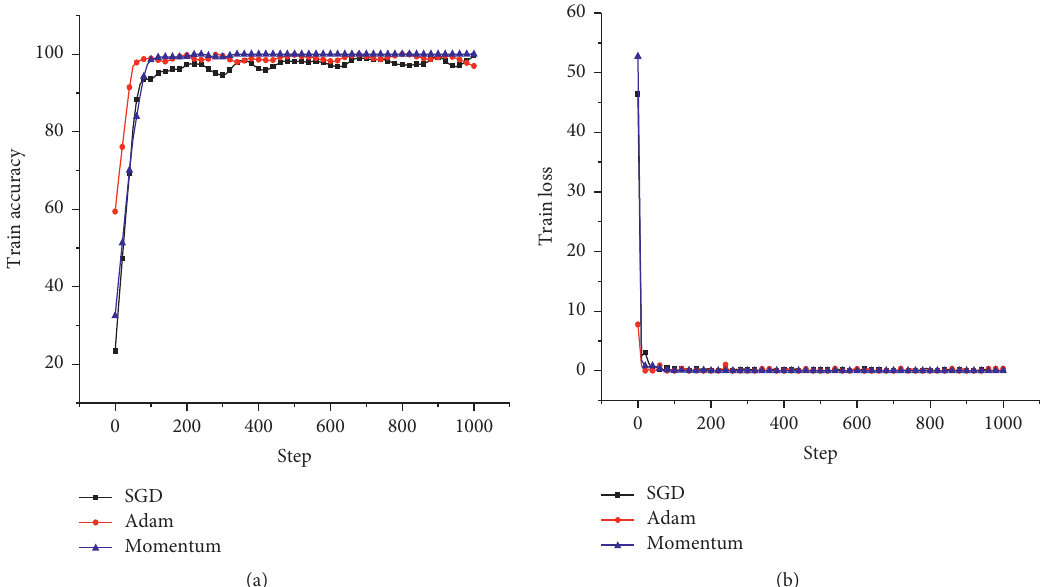
Figure 11: Comparison of different optimizer training effects: (a) training accuracy; (b) training loss. Table 4: Comparison of different optimizer test results.